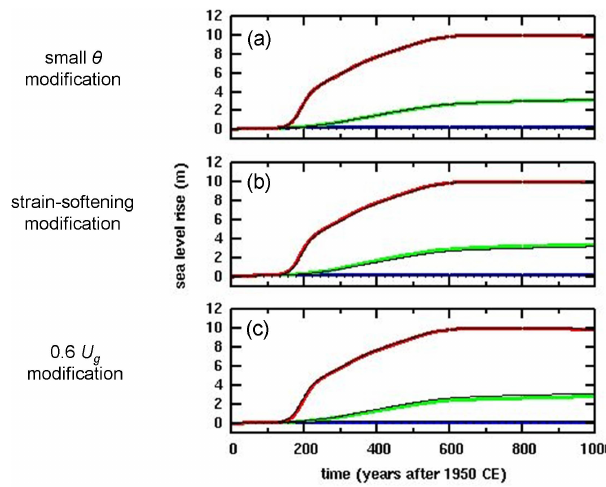
Figure B2. Equivalent global sea level rise in simulations of fu- ture West Antarctic ice retreat with climate forcing based on the RCP8.5 greenhouse-gas scenario (a) with small θ modification de- scribed in Sect. B1, (b) with strain-softening modification described in Sect. B2, and (c) with 0 . 6 U g modification described in Sect. B3. Thick colored lines: as in the main paper except with one of the above modifications. Thin black lines: as in the main paper with no further modification. Blue: control (perpetual modern climate). Green: with RCP8.5 forcing, without hydrofracturing or cliff fail- ure. Red: with RCP8.5 forcing, with hydrofracturing and cliff fail- ure.